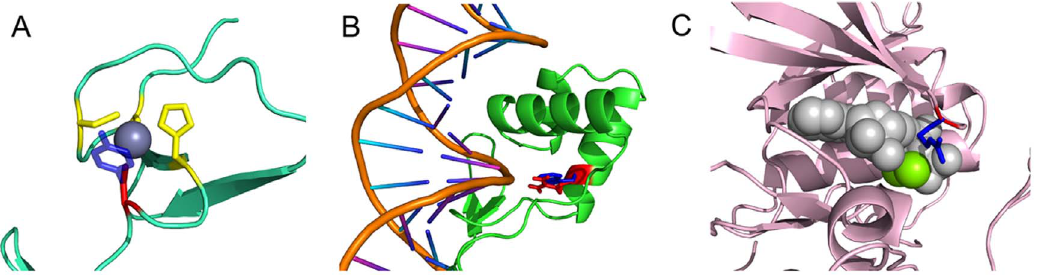
Figure 3. Examples of mutations on protein-nucleic acid and protein-ion interactions. Residues at mutated sites on homologous proteins are shown in red (wild type) and blue (mutant) stick models. ( A ) Zinc binding motif of LMO-2, homologous protein of LMX1A (PDB: 2XJY chain A, sequence identity 35%). A zinc ion is shown as a dark blue sphere. Zinc binding residues are shown in yellow stick models. ( B ) DNA binding site of Pax-6 , homolog of Pax-9 (PDB: 6PAX chain A, sequence identity: 74%). ( C ) MAPK10 , homolog of MAPK9 , with Mg-ANP (ATP analog) (PDB: 1JNK chain A, sequence identity: 85%). Mg ions are shown as green spheres and ANP is shown using a white sphere representation.